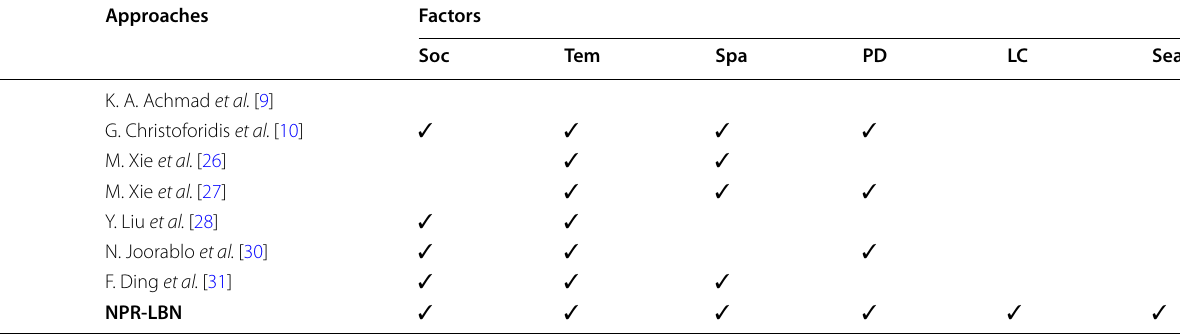
Table 1 Incorporating factors in existing